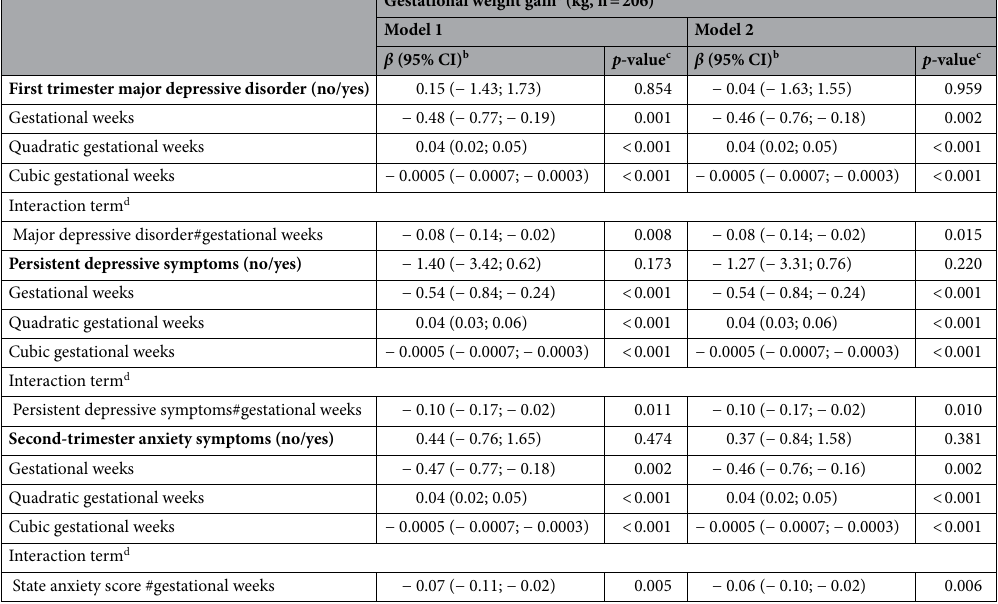
Table 2. Association between maternal mental health during pregnancy and gestational weight gain for women followed at a public health care center in Rio de Janeiro, Brazil, 2009–2012. Major depressive disorder was assessed using Mini-International Neuropsychiatric Interview. Persistent depressive symptoms were classified as ‘yes’ if the women presented Edinburgh Postnatal Depression Scale score ≥ 11 at the three pregnancy trimesters. State anxiety symptoms were measured using the Spielberger State-Trait Anxiety Inventory. Model 1 was adjusted for linear, quadratic, and cubic gestational weeks; Model 2 was further adjusted for desire to be pregnant, education, marital status, pre-pregnancy leisure time physical activity, parity, and pre-pregnancy body mass index. a Cumulative gestational weight gain; b Longitudinal linear regression coefficient and 95% confidence interval (CI); c p-value refers to maximum likelihood estimator; d The interaction term between mental health status and gestational weeks tests whether there were different trajectories of gestational weight gain according to the categories of the mental health status